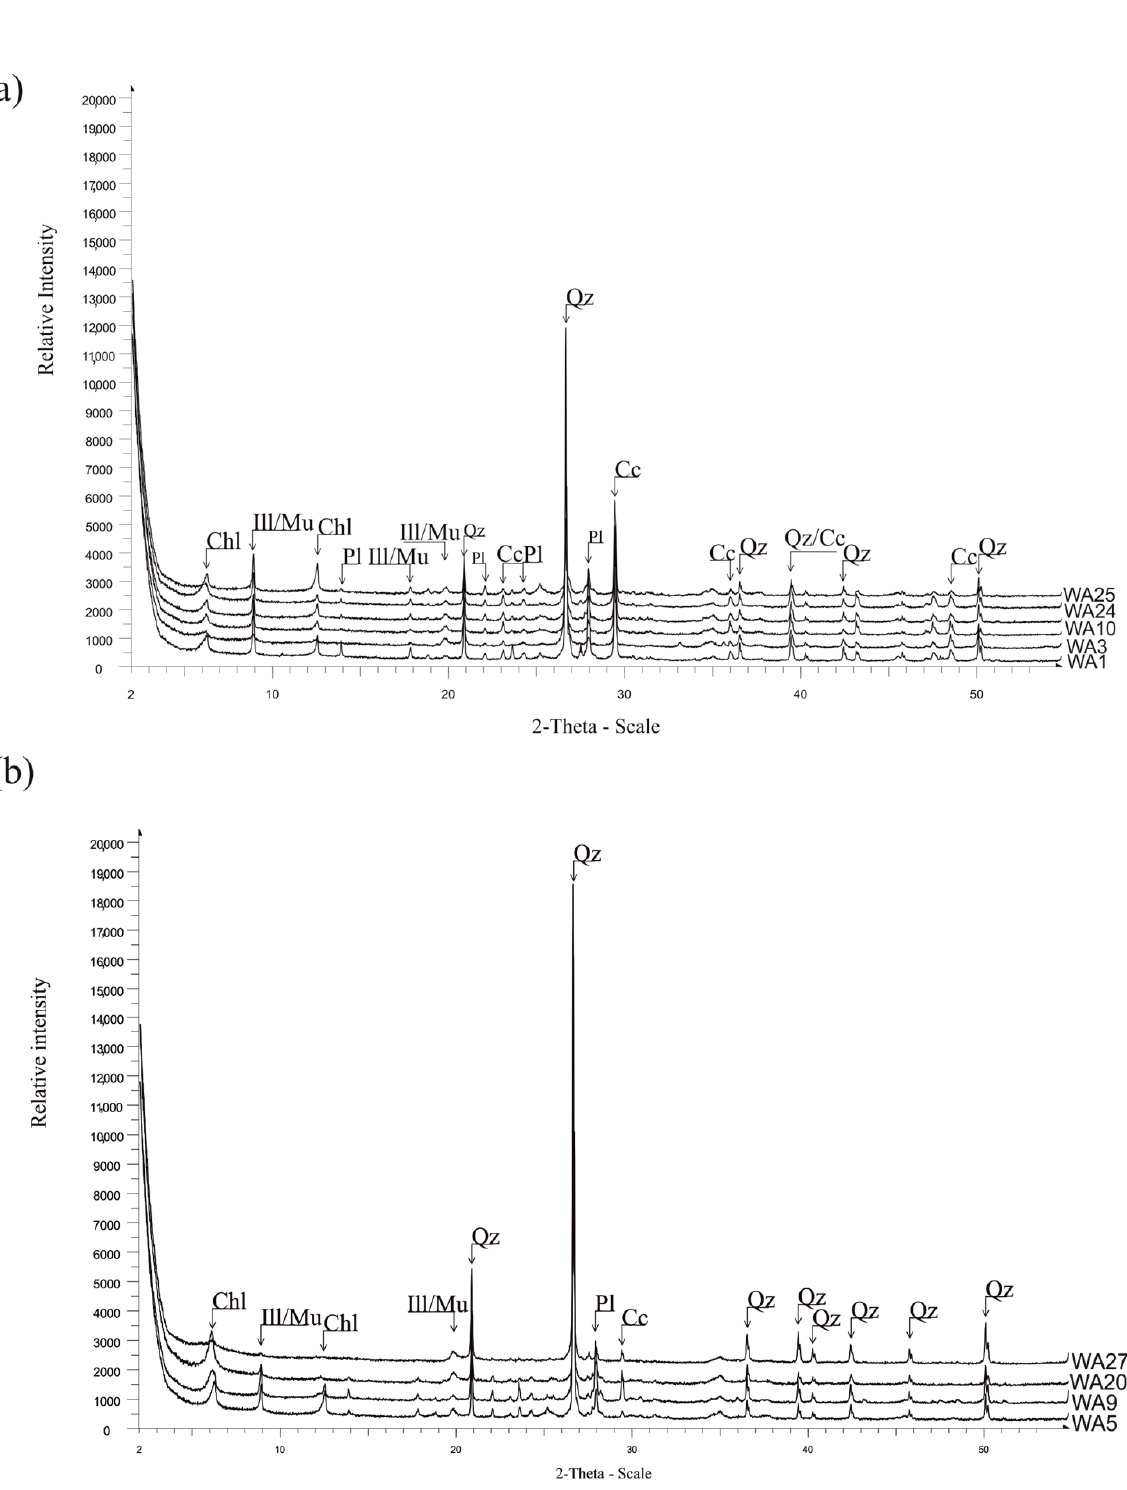
Figure A1. Representative composite X-ray diffractograms of the samples from WA: ( a ) calcareous and ( b ) non-calcareous. Abbreviations: Qz = Quartz, Cc = Calcite, Pl = Plagioclase, Chl = Chlorite, Ill = Illite, Mu = Muscovite.